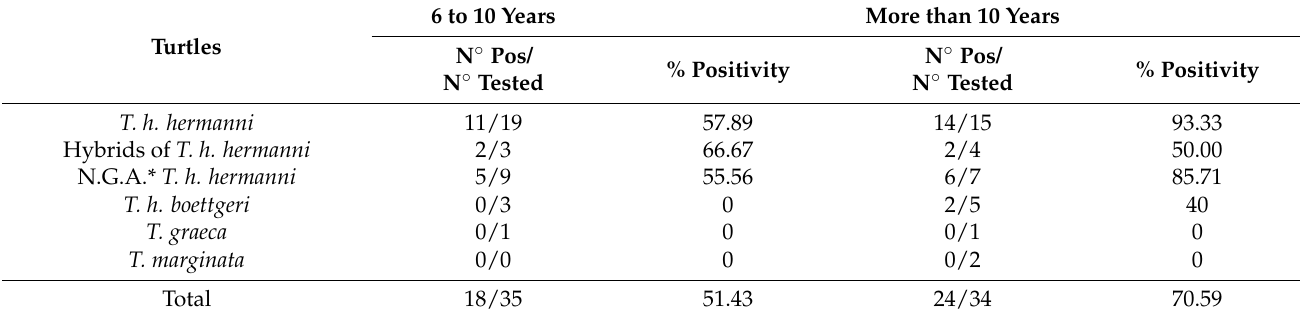
Table 2. Prevalence of Salmonella spp. in relation to the age of the turtles.